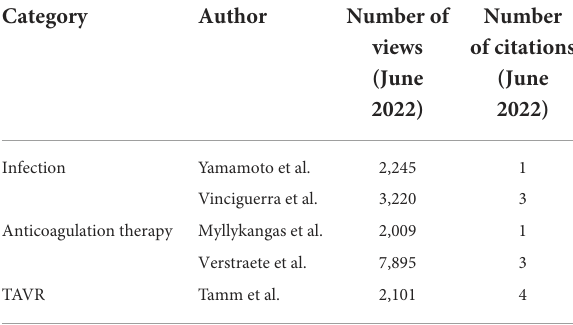
TABLE 1 Top articles published in 2021 at Heart Valve Disease